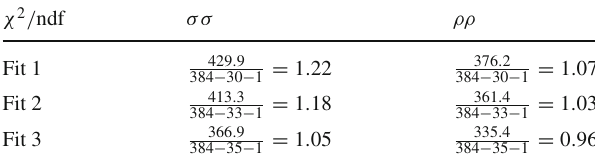
Table 1 Reduced χ 2 for the best fits. See main text for